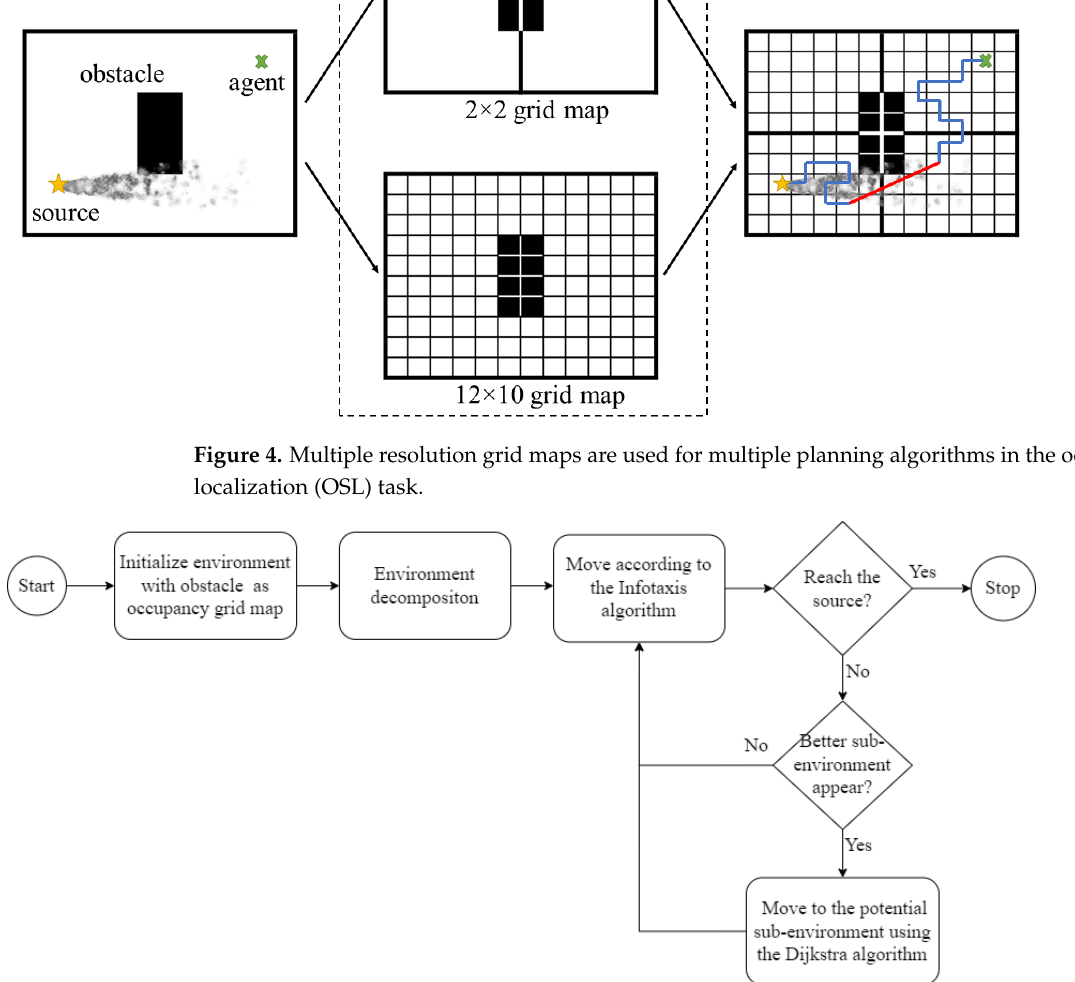
Figure 5. The workflow of the planning algorithms